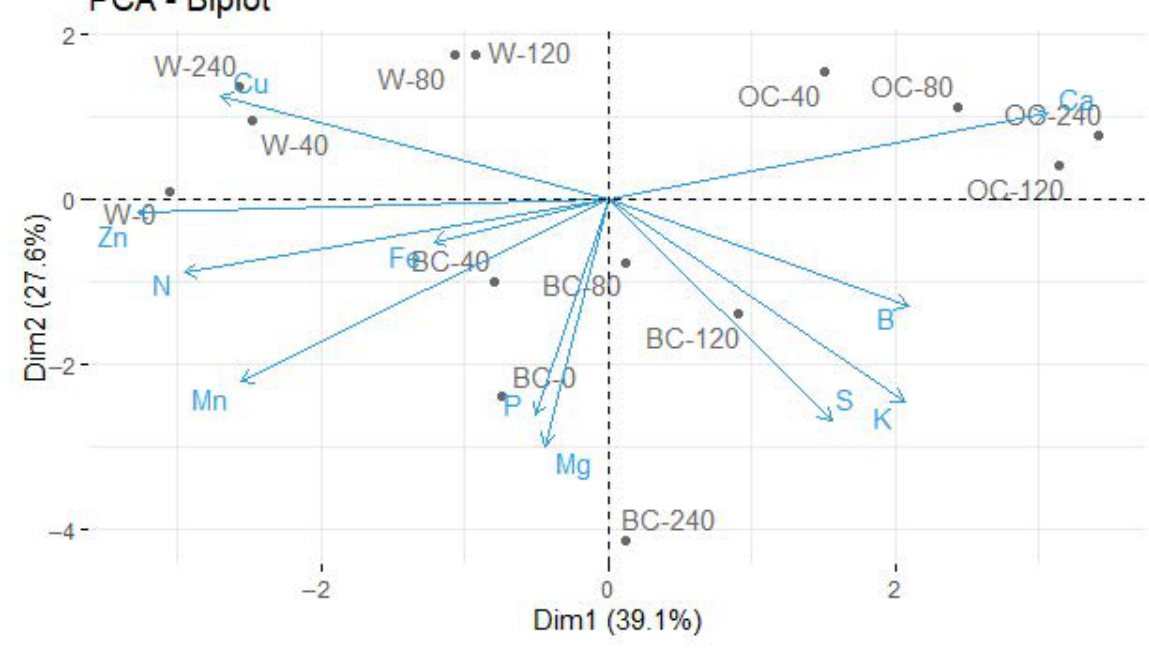
Figure 4. Principal component analysis of the macro- and micronutrient contents in the shoots of D. apurensis as a function of P dose in waste without organic amendments (W), with biochar (BC), and with organic compost